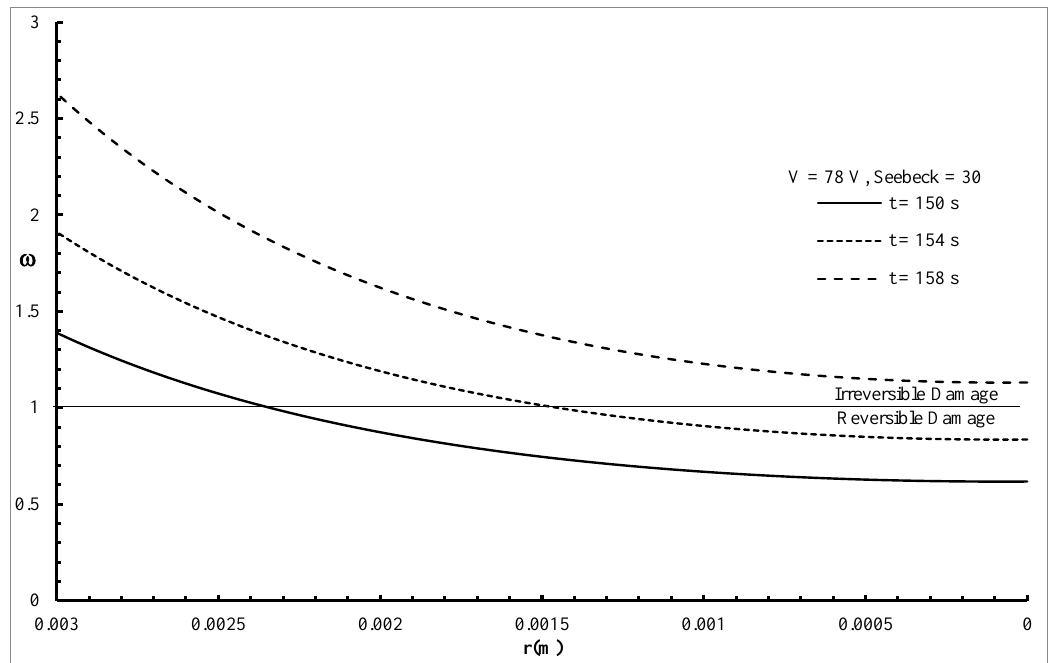
Figure 15 . The thermal damage distribution of liposarcoma tumor with various values of time when Figure 15. The thermal damage distribution of liposarcoma tumor with various values of time when 600 R   . e R e = 600 Ω